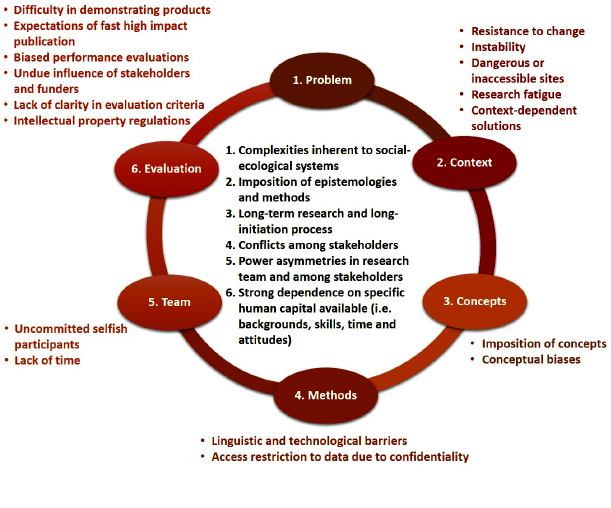
Fig. 5. Features, undesirable aspects, and obstacles that hinder the success of place-based social-ecological research. Crosscutting features are in the center. Different types of features related to this type of research are outside the